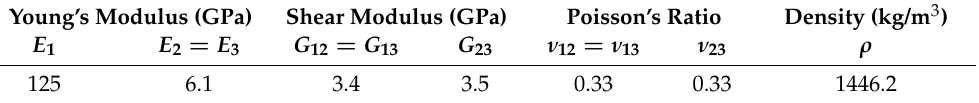
Figure 2. Illustration of the cantilevered composite plate with the parameters used to describe the delamination size and location. Table 1. The elastic material constants of the carbon fiber-reinforced epoxy composite lamina Young’s Modulus